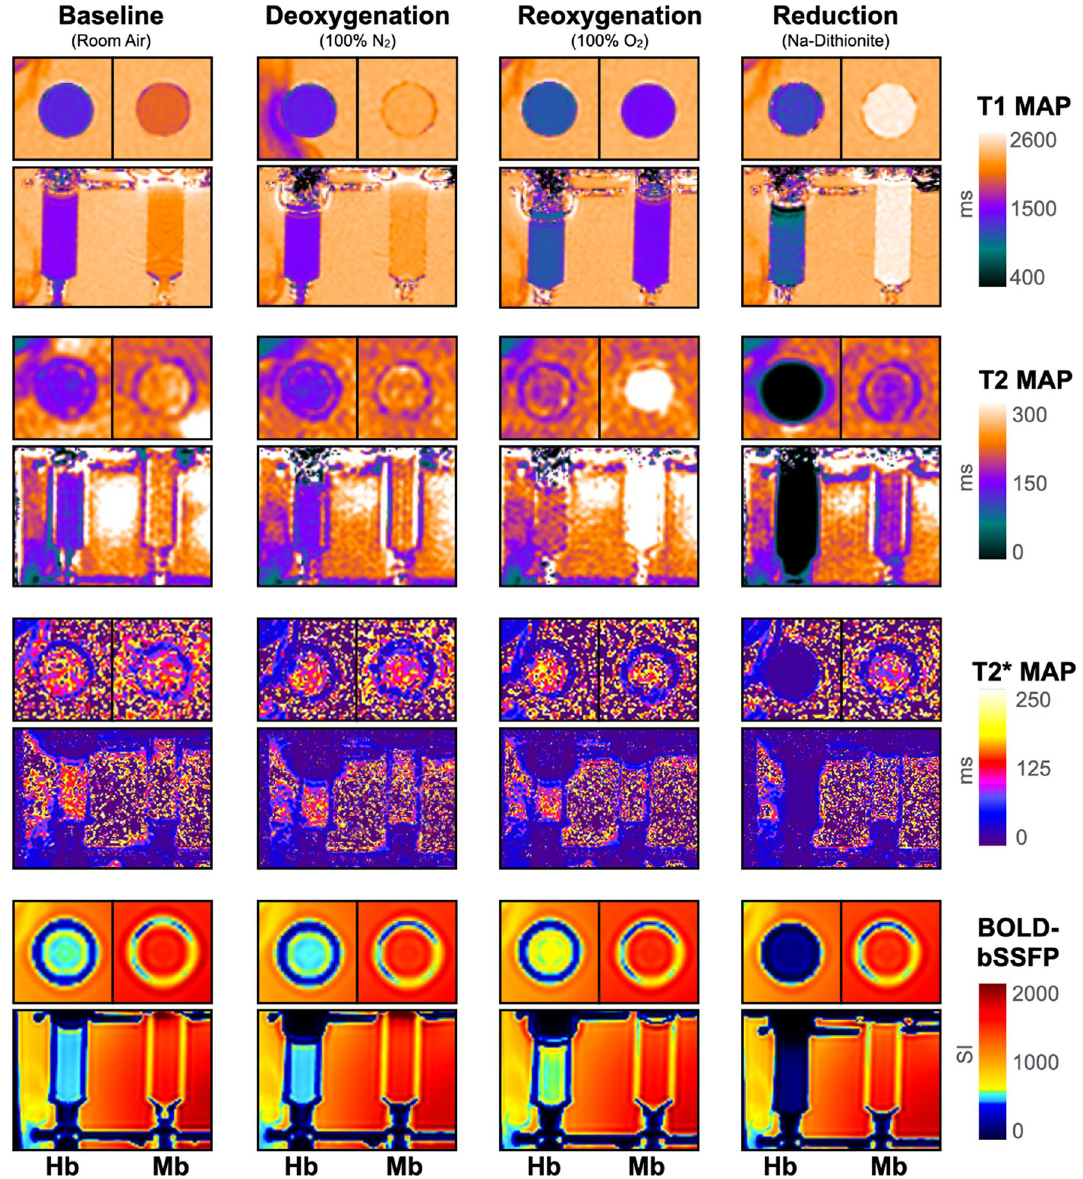
Figure 3. MRI imaging of myoglobin and hemoglobin: Horizontal and vertical cross-section views are shown of representative T1 maps, T2 maps, T2* maps and blood oxygen level-dependent balanced steady state free precession (BOLD-bSSFP) of red blood cells and dissolved myoglobin in modified test tubes at each major oxygenation state. On the left side a hemoglobin sample is shown, while on the right side a myoglobin sample is shown within the same imaging plane and for all acquired imaging sequences, respectively. Image prepared using Circle cvi 42 version 5.13 (www. circl ecvi.